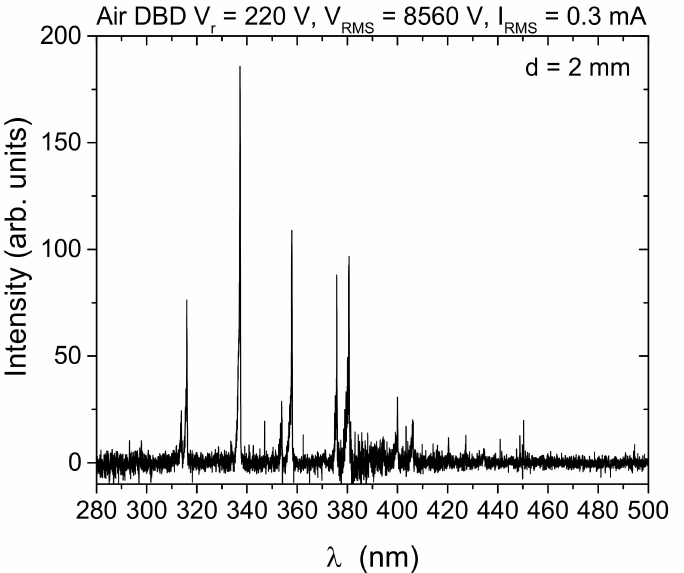
Figure 10. Optical emission spectrum from an air SDBD source obtained from side-on recording of spatially integrated emissions from the whole discharge volume (electrode gap, d = 2 mm). The intensity signal is corrected for spectral efficiency of the optical